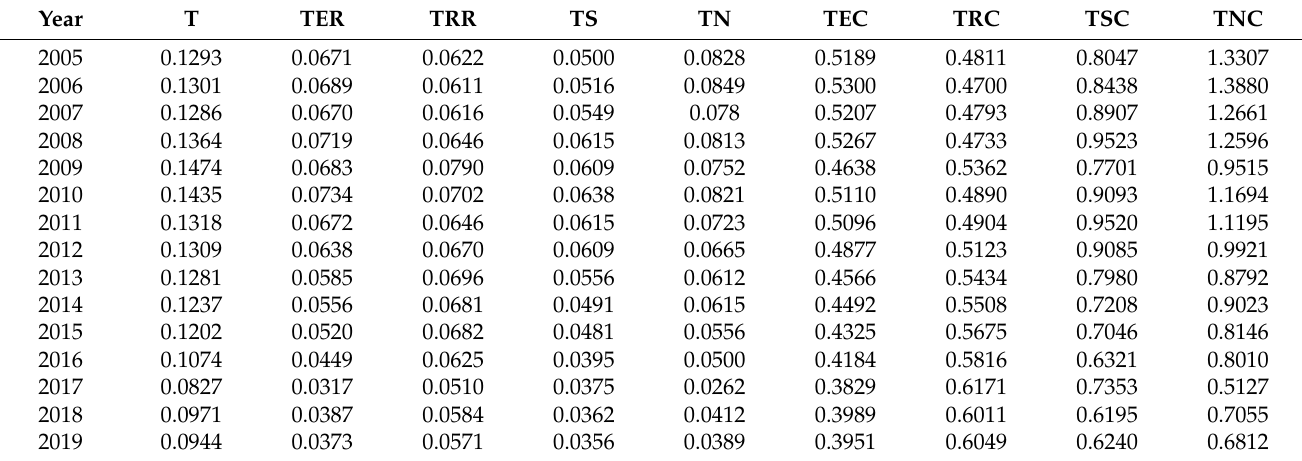
Table 6. Theil coefficient and its decomposition of development level of open economy in YRDA from 2005 to 2019.